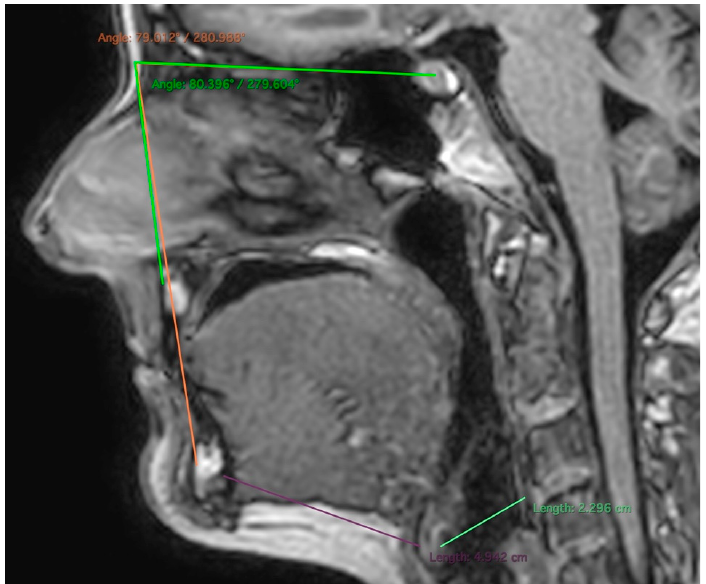
Figure 1. T1 weighted cephalometric measurements on midsagittal plane. (Green: SNA angle, orange: SNB angle, purple: mandibular-hyoid distance, light green: hyoid–cervical tangent distance).